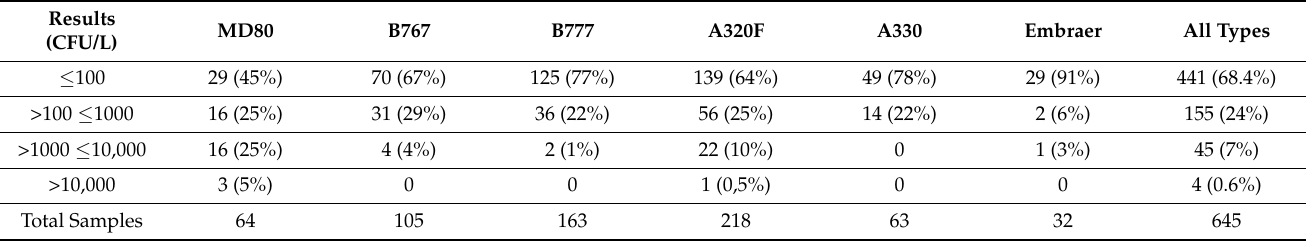
Figure 5. Number of examined airplanes (blue) and number of Legionella- positive airplanes (orange) for the entire period of examination.